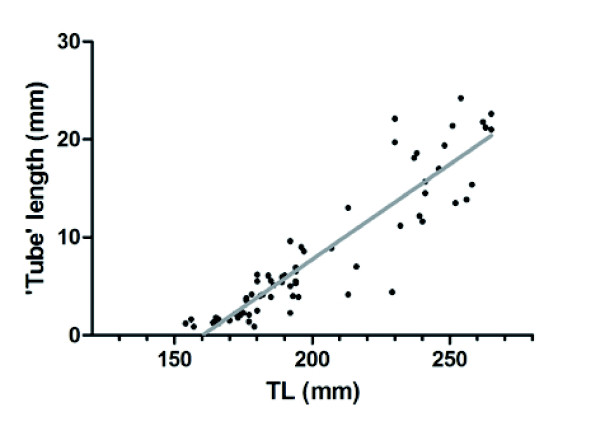
Relationship between swimbladder internal tube length and body size in male Ophidion rochei. There was a high correlation (r2 = 0.83 (N = 68), p < 0.0001) between the internal tube length and the total length of the fish. Black dots: observations for the 68 males Ophidion rochei from Costa Brava. Grey line: regression line (y = 0.1944x – 31.14) calculated for the 68 male swimbladders.